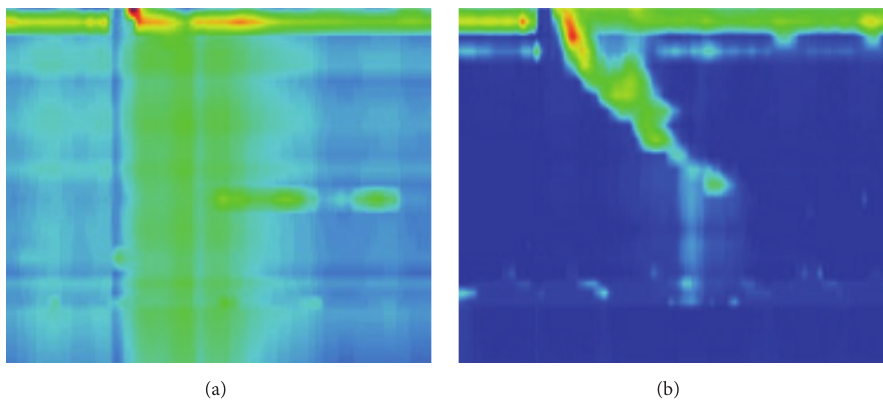
Figure 3: (a) A case of preoperative manometry showed Type II (absence of normal peristalsis and panoesophageal pressurization with ≥ 20% of swallows). (b) Postoperative manometry showed significant amelioration of panoesophageal pressurization.